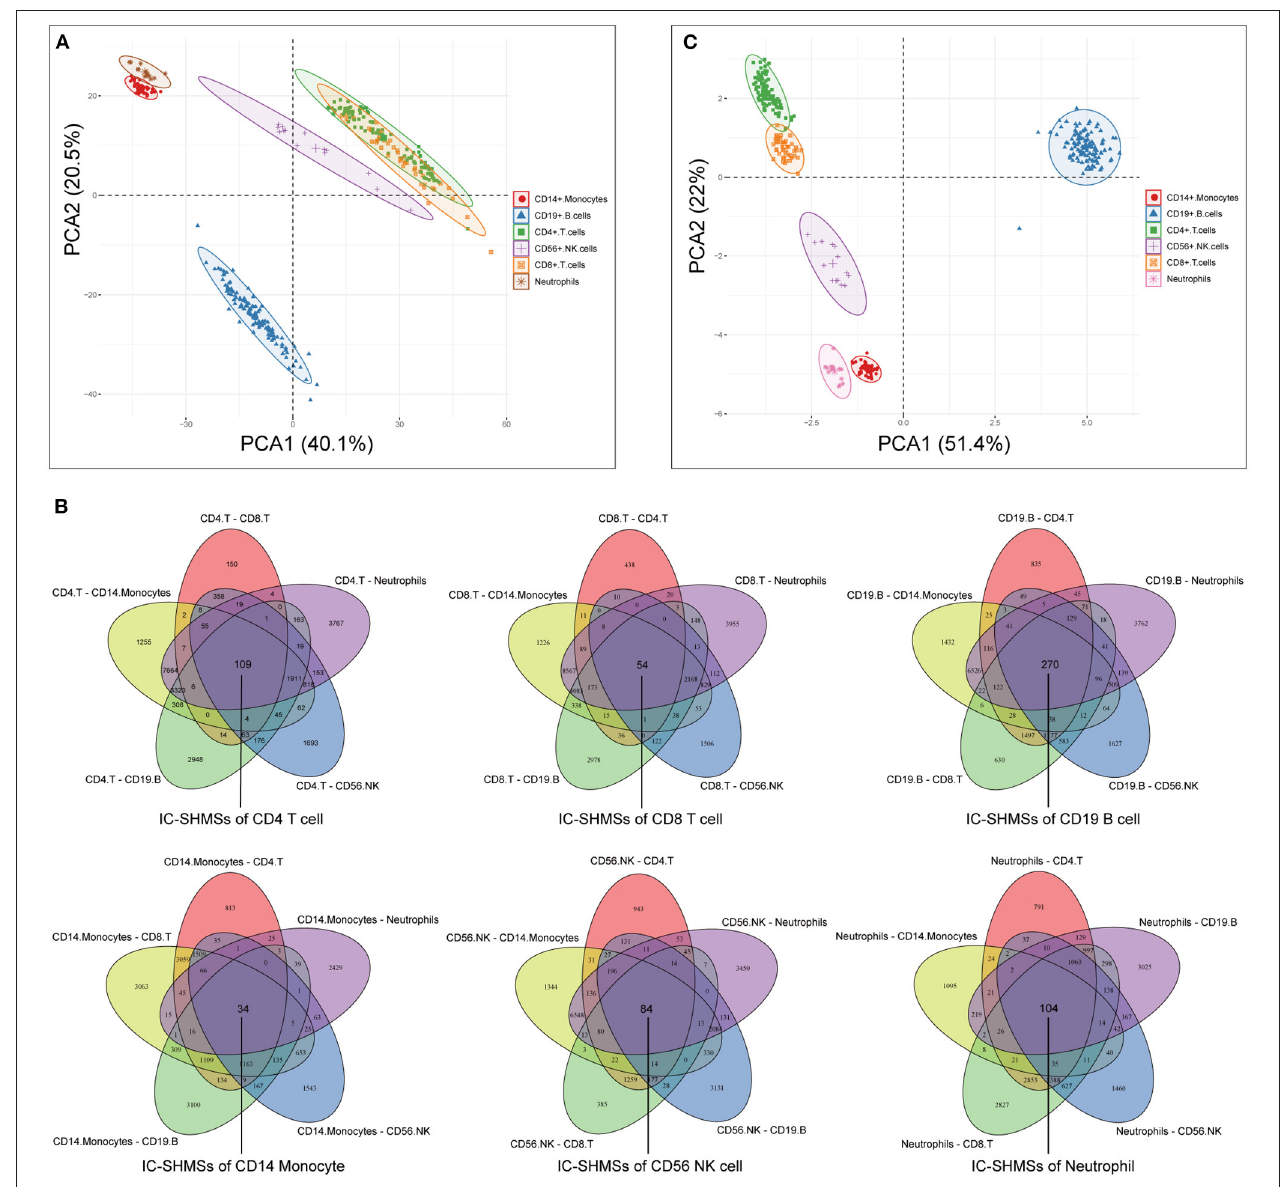
FIGURE 2 | Identification of the IC-SHMSs of six immune cell types. (A) PCA plot of six immune cell types based on the whole methylation profiles. (B) Venn diagrams showing the IC-SHMS numbers of each immune cell; a total of 655 IC-SHMSs was identified. (C) PCA plot of six immune cell types based on the methylation profiles of the 655